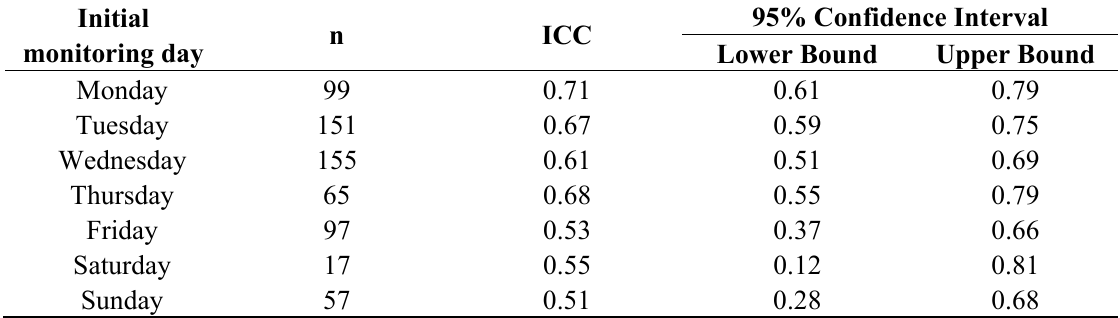
Table 2. Intra-Class Correlations [ICC (3,7)] and 95% confidence interval by starting